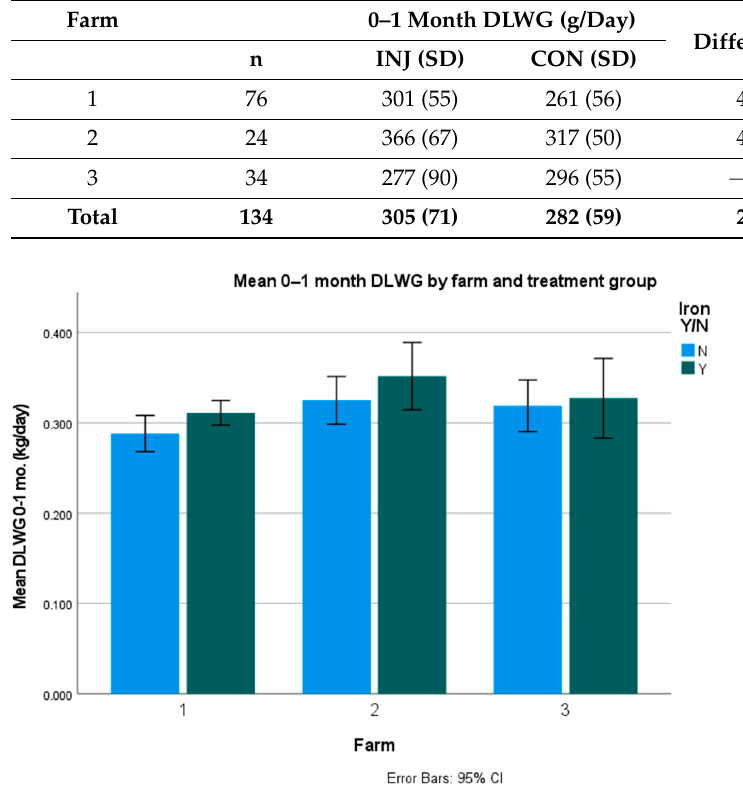
Figure 1. Mean overall DLWG on the farms with error bars (kg/day). Table 5. Overall DLWG in lambs, 0–1 month, singles only.